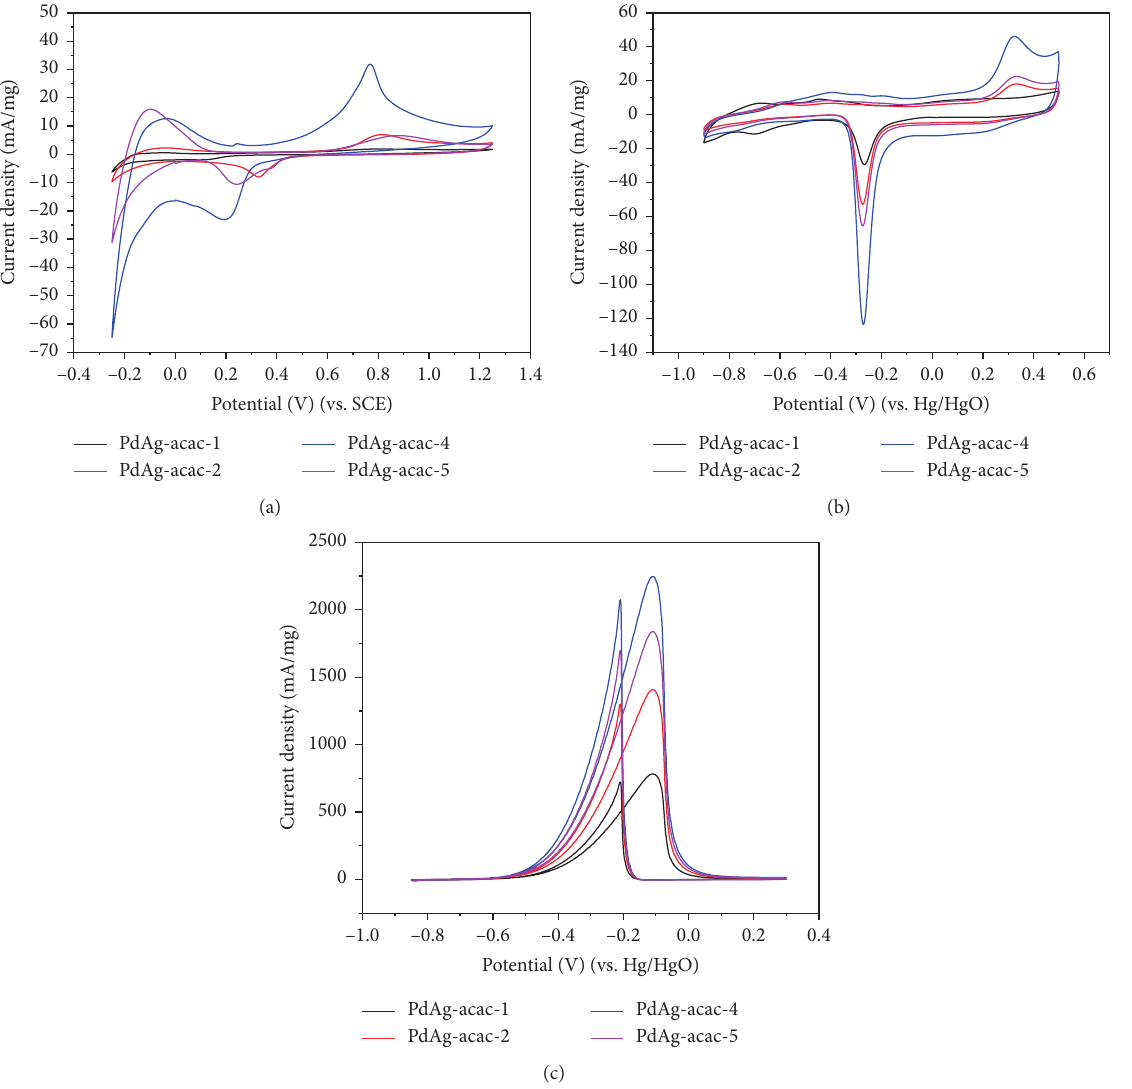
Figure 5: CV curves of the GCEs modified by PdAg-acac-1, PdAg-acac-2, PdAg-acac-4, and PdAg-acac-5 in aqueous solutions containing 0.5M H 2 SO 4 (a), 1M KOH (b), and 1 M KOH/1M C 2 H 5 OH (c) at a scan rate of